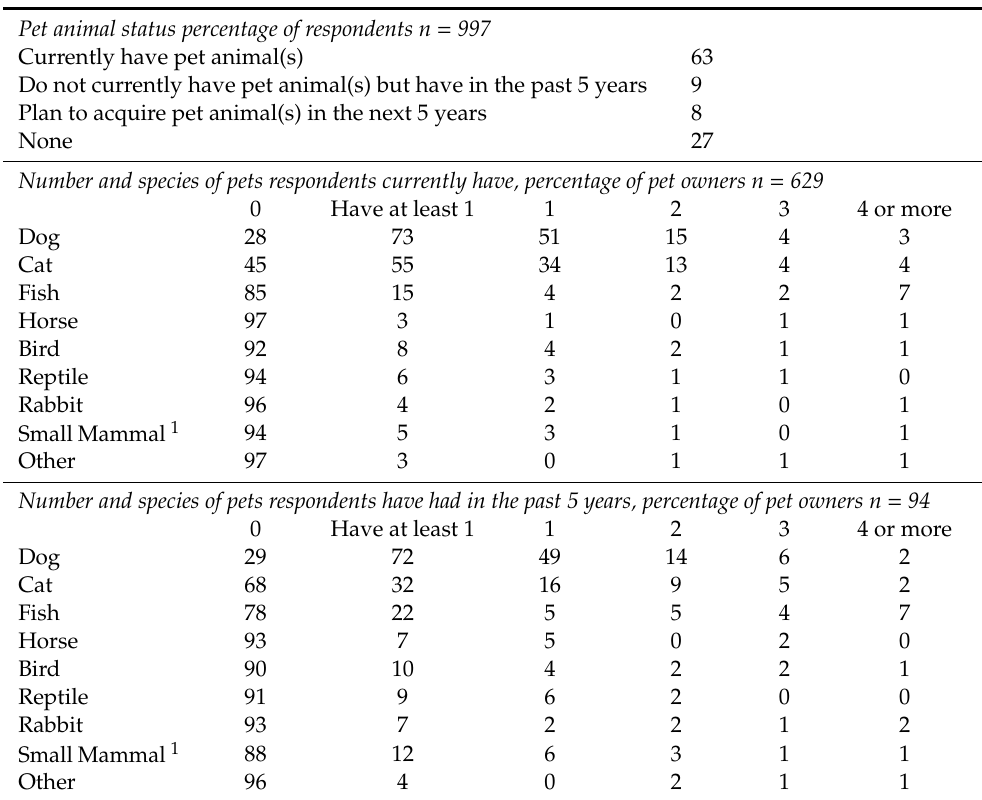
Table 2. Respondent pet ownership including type and number of pets, percentage of